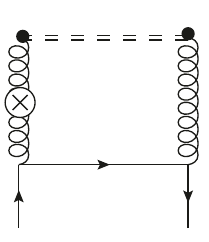
Figure 1 . One-loop quantum correction to S gq